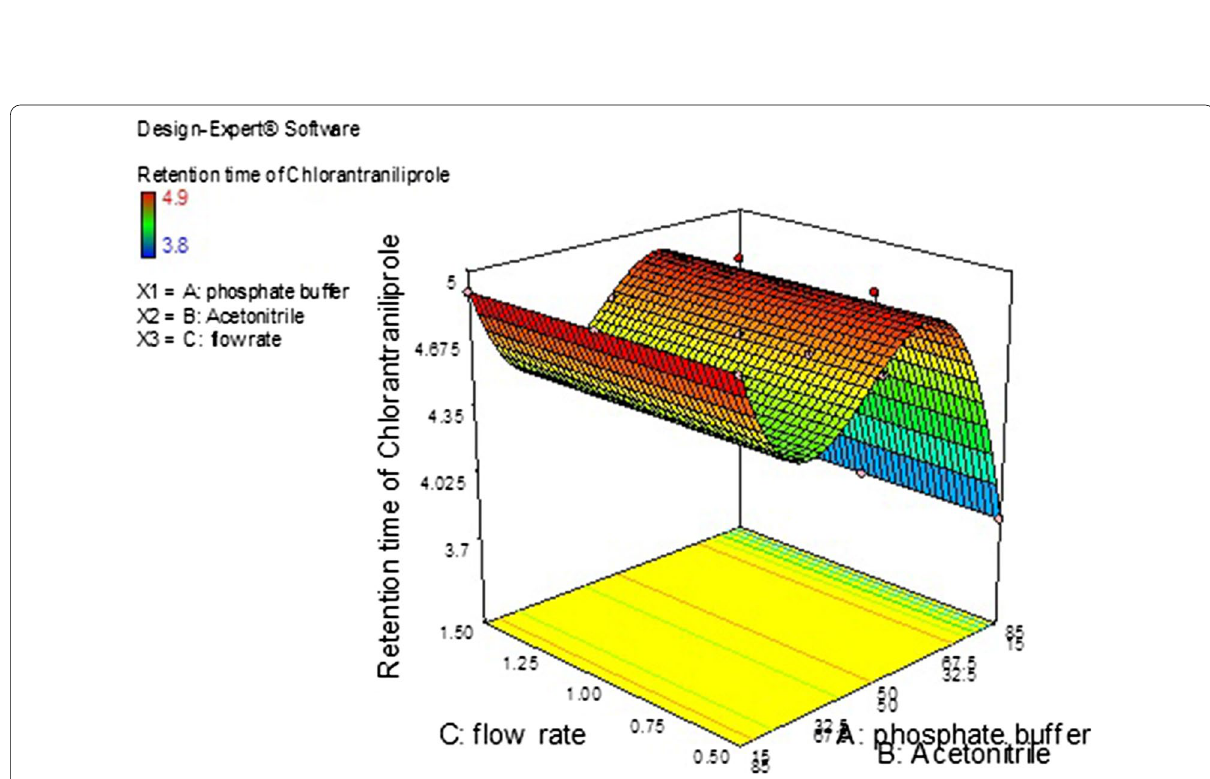
Fig. 3 3D surface plots showing retention time of chlorantraniliprole as